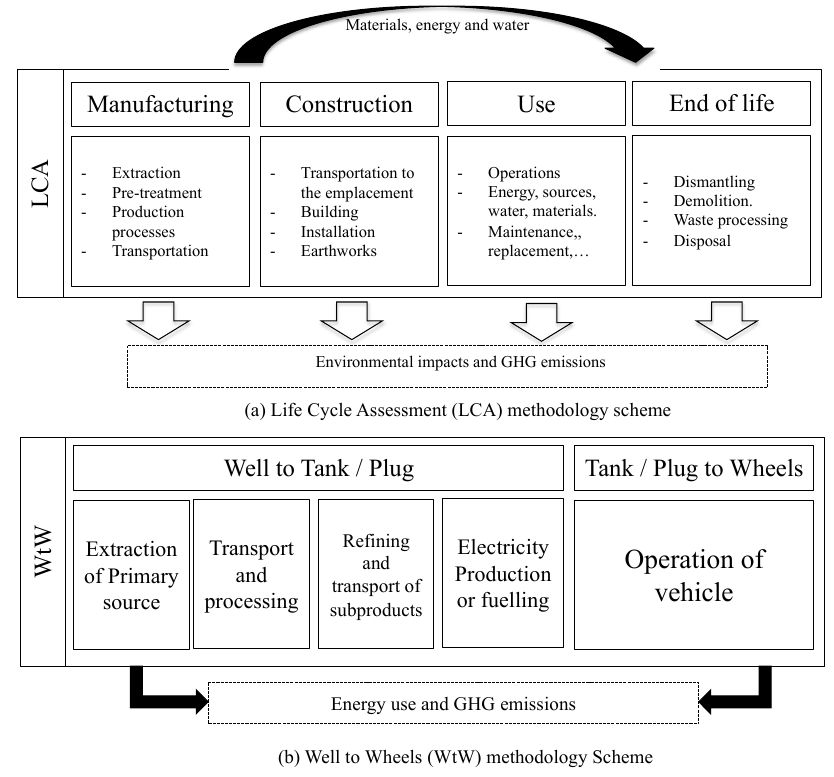
Figure 1. Life cycle assessment and well-to-wheels methodology schemes.